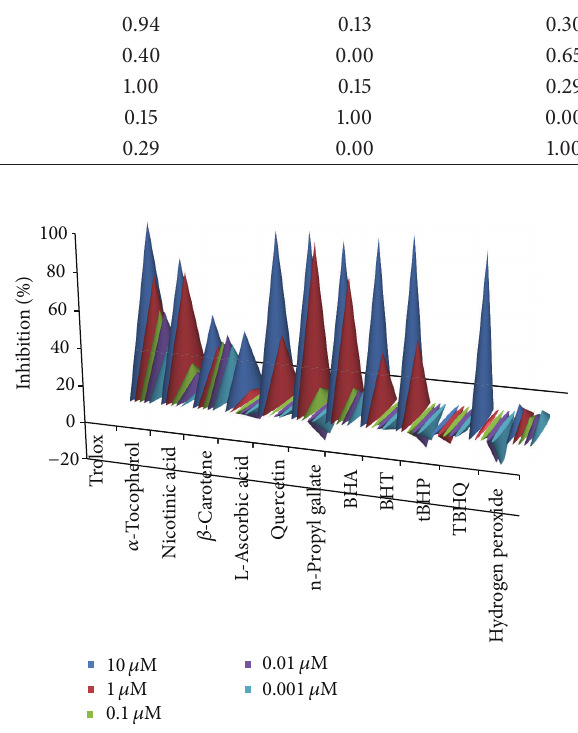
Figure 8: Percent inhibition is calculated from peak values of the kinetic data with respect to control. Peak values represent maximum OD of the compound at this